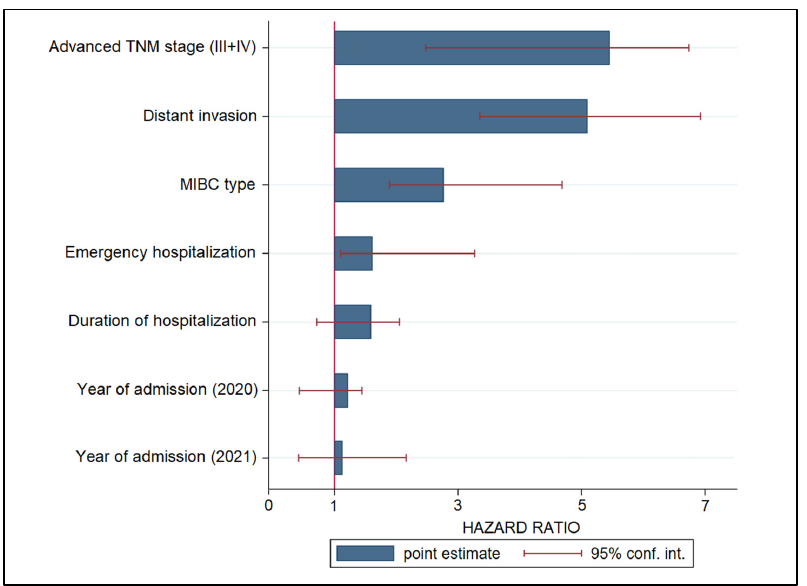
Figure 3. Analysis of risk factors for disease progression in patients with urothelial